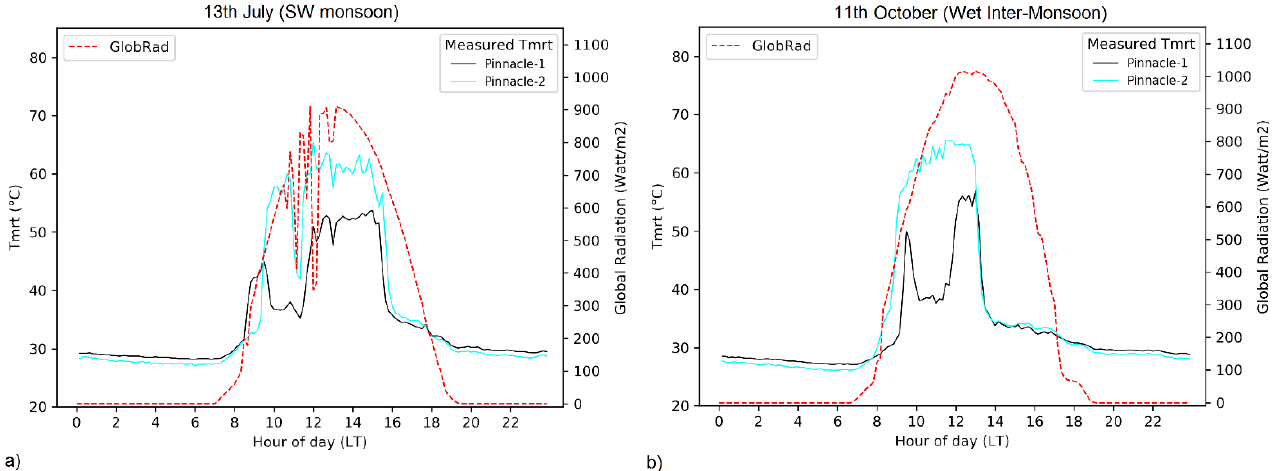
Figure 7. Diurnal cycle of T mrt (using 10-min averaged values) and global incoming solar irradiance (using 10-min values) in Pinnacle1 and Pinnacle2 on ( a ) 13 July and ( b ) 11 October 2019